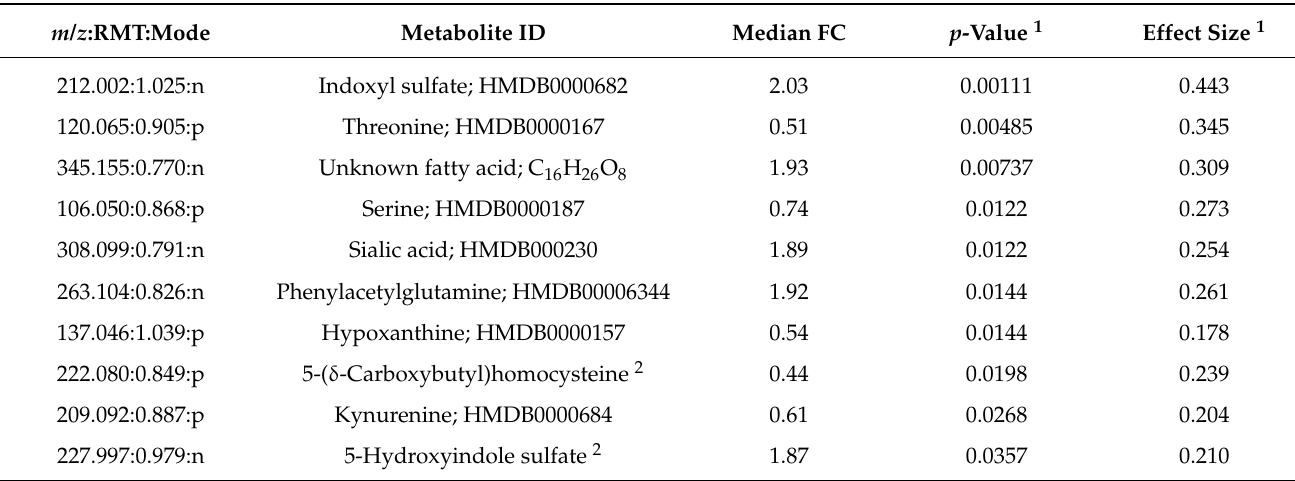
Table 2. Top-ranked urinary biomarkers (sum-normalized) identified by MSI-CE-MS that differentiate pediatric CD ( n = 18) from UC ( n = 8) patients prior to induction therapy.